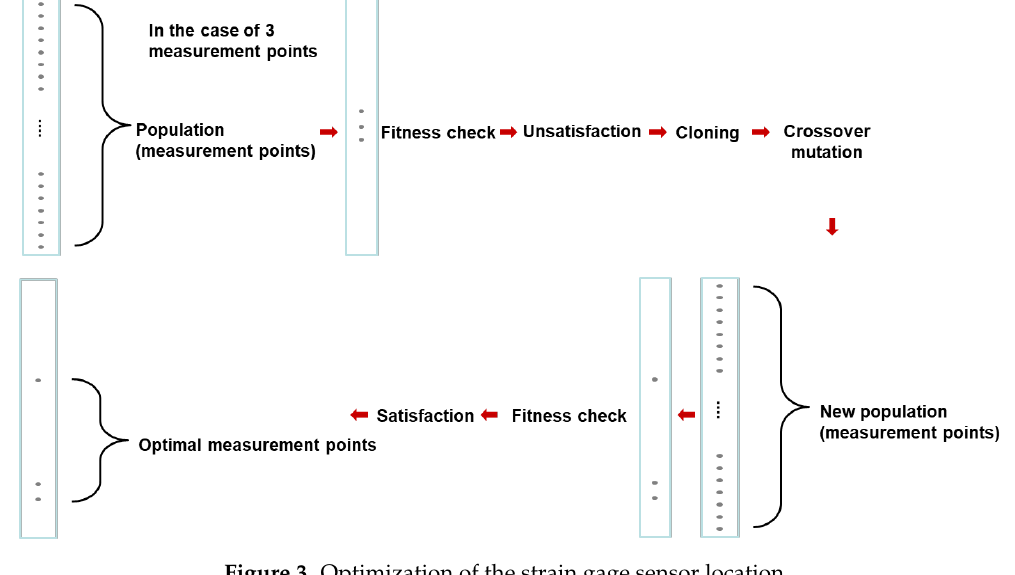
Figure 3. Optimization of the strain gage sensor location.